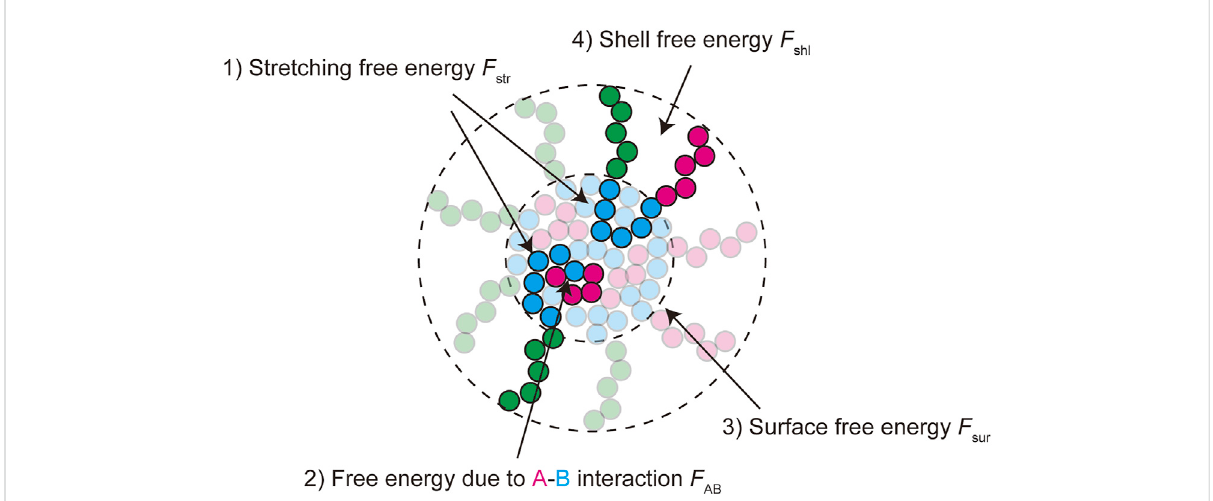
FIGURE 3 The free energy of a paraspeckle is composed of fi ve terms: 1) the stretching free energy of blocks in the core F str , 2) the free energy due to the repulsiveinteractionsbetweenAandBunitsinthecore F AB ( ≈ χ AB N A n ) ,3)thesurfacefreeenergy F sur ( ≈ N − 1/3 B n 5/3 ) ,4)thefreeenergyoftheshell F shl ( ≈ N A N − 5/9 n 23/18 ) ,and5)themixingfreeenergy F F F B mix .Thefreeenergycontributions AB and sur representthe(free)energeticpenaltybecauseBunits at the vicinity of A units in the core and at the surface have a lesser number of partners of multivalent